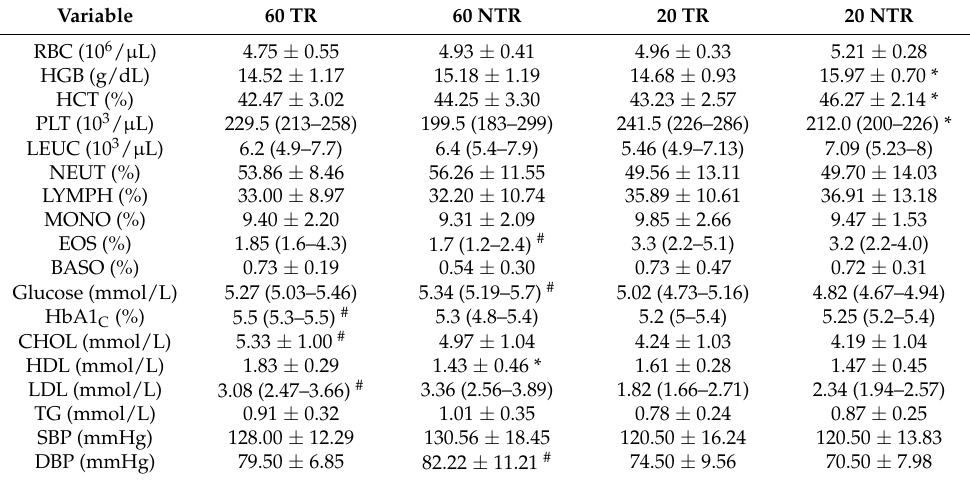
Table 1. Heamatological and biochemical indices of the